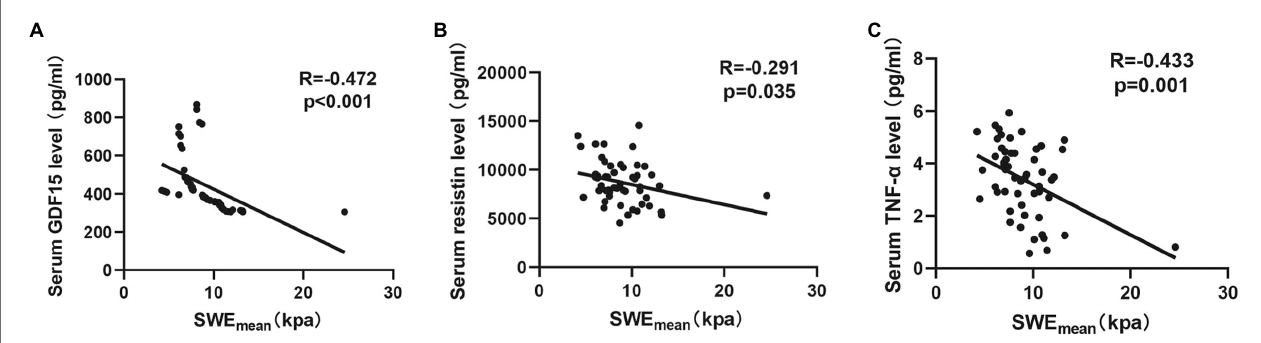
FIGURE 3 | The relationship between circulating biomarkers and the mean elasticity indices of rectus femoris ultrasound elastography in patients with COPD. (A) The relationship between SWE mean and serum GDF15 level; (B) The relationship between SWE mean and serum resistin level; and (C) The relationship between SWE mean and serum TNF- α level. SWE mean : mean SWE elasticity